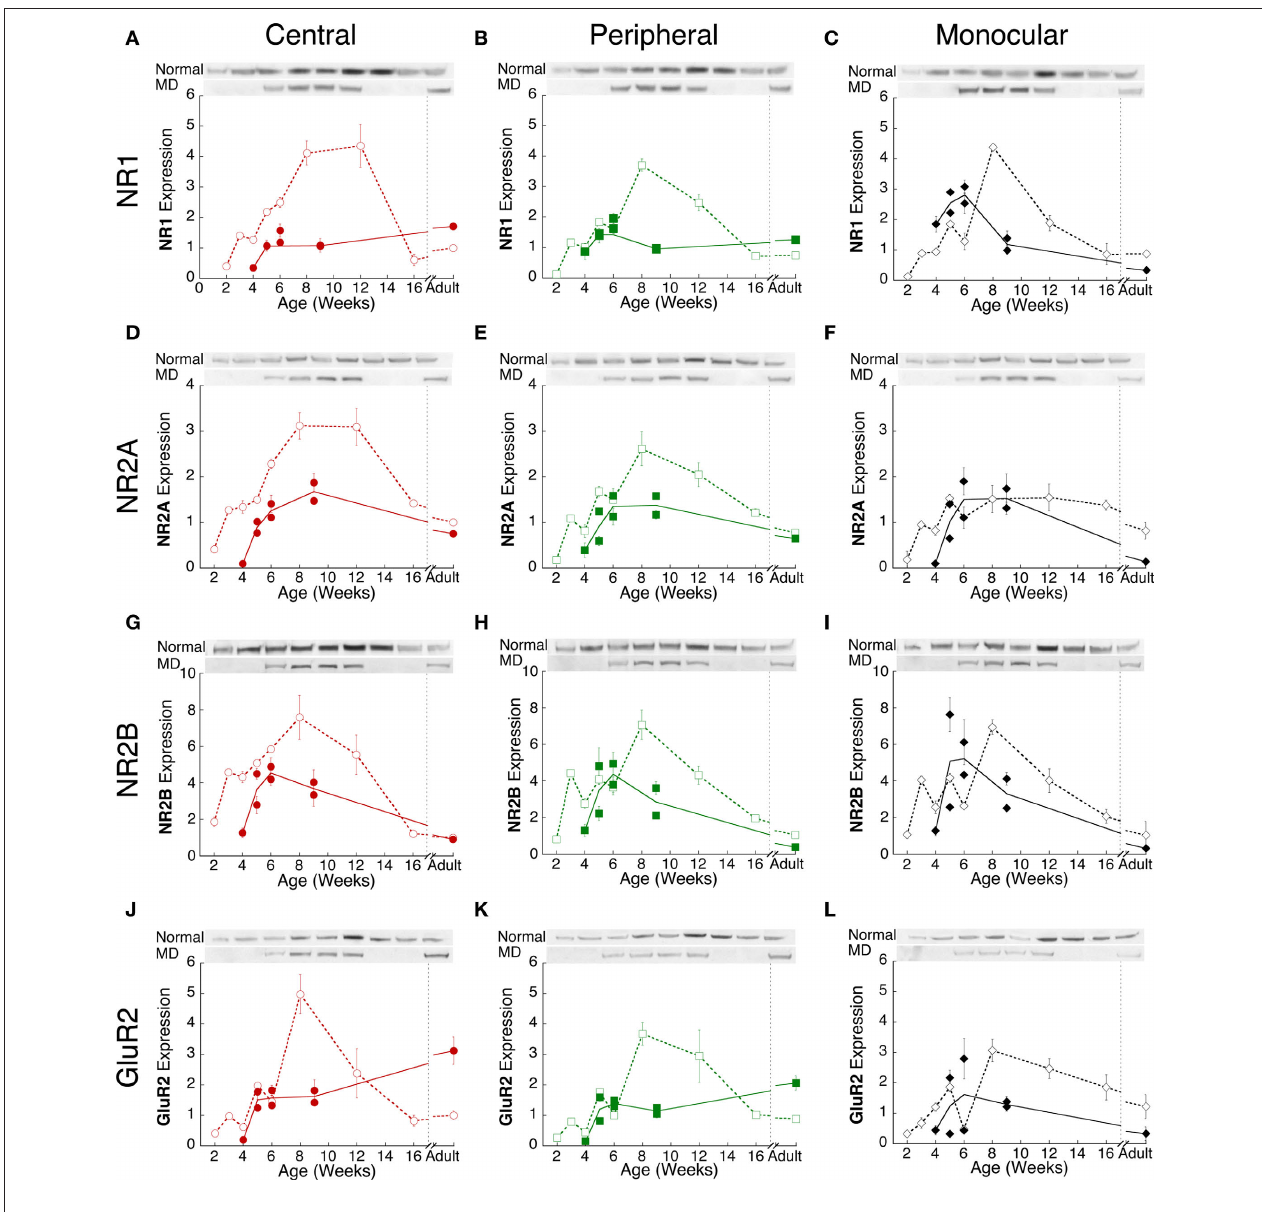
monocular (black diamonds) visual field representations during postnatal development. For each subunit, the plots were normalized relative to the average normal adult expression in the central visual field. Error bars indicate the s.e.m. Representative Western blot bands are shown above each